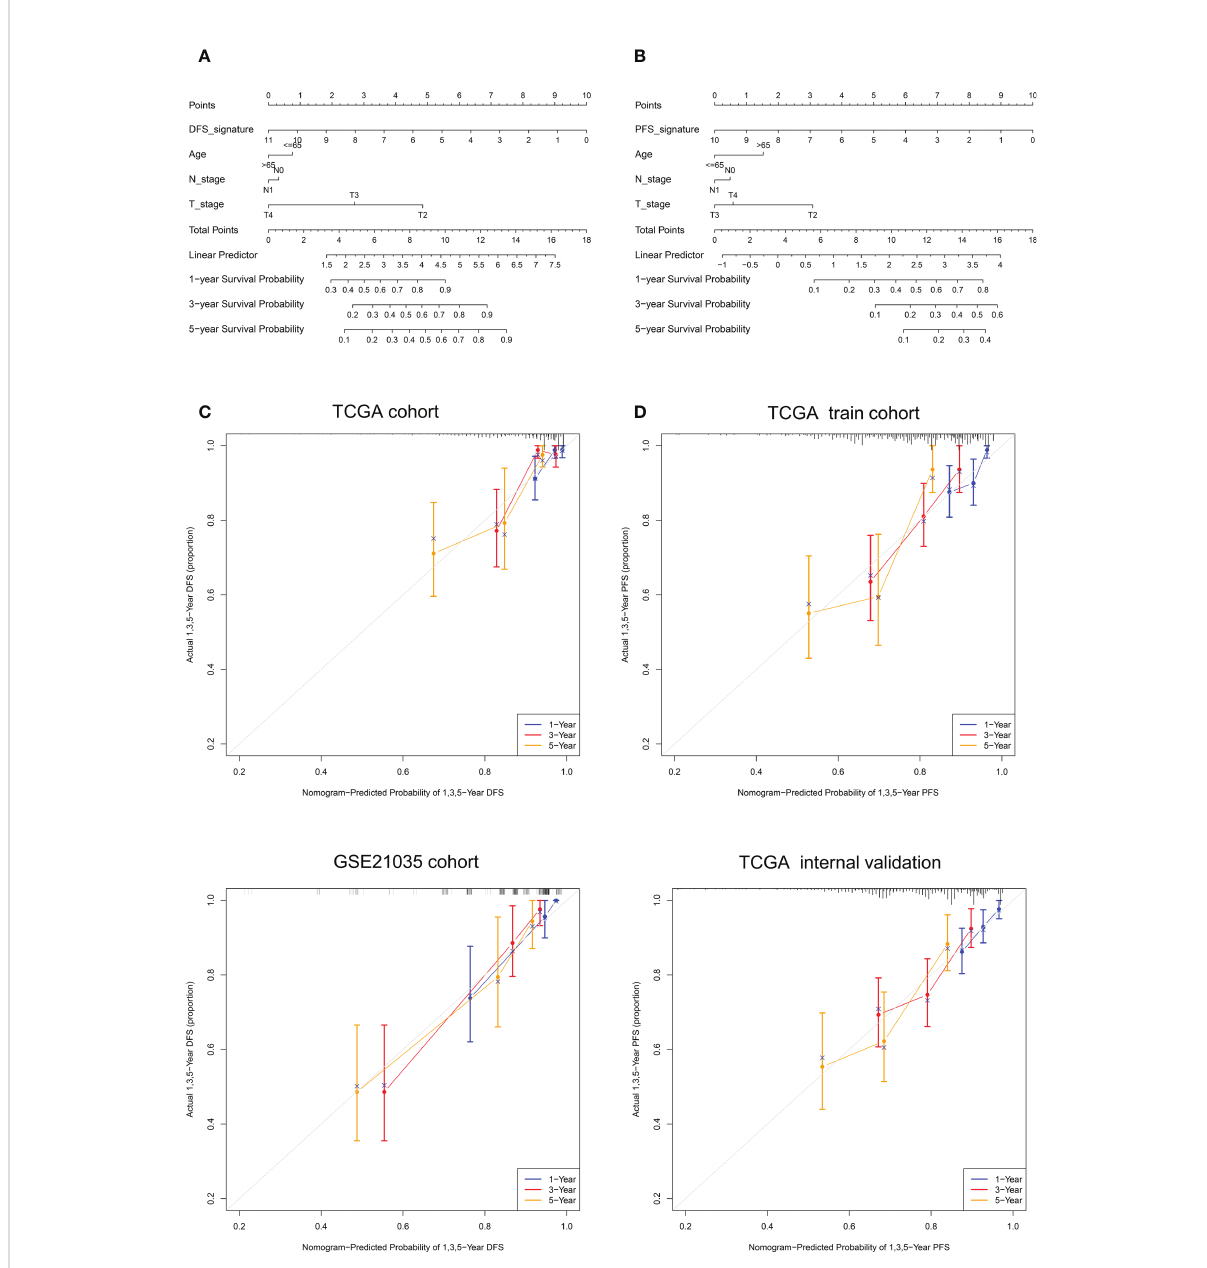
FIGURE 11 Nomogram construction and calibration plot validations for DFS and PFS prediction in PCa. (A, B) The composite nomogram consists of the DFS- or PFS- signature and clinical features of the individual patient, by adding the points from variables listed together, the 1-,3- and 5-year survival (DFS or PFS) probability can be inferred by the clinician. (C, D) Calibration curves for validation the consistence between 1-, 3- and 5- year (blue, red and orange color, respectively) inferred DFS and actual data in TCGA cohort and GSE21035 cohort. The dashed line represents the best match between the nomogram-predicted probability and the actual data evaluated by Kaplan – Meier